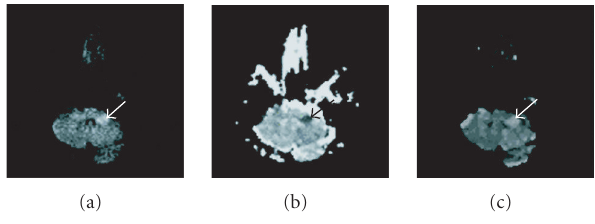
Figure 2: The same patient as Figure 1. Hyperacute stage (1.5 hour). The images are DWI (a), ADC map (b), and EADC map (c), respectively. The hyperintense signals in DWI, EADC map, and hy- pointense signal in ADC map can be